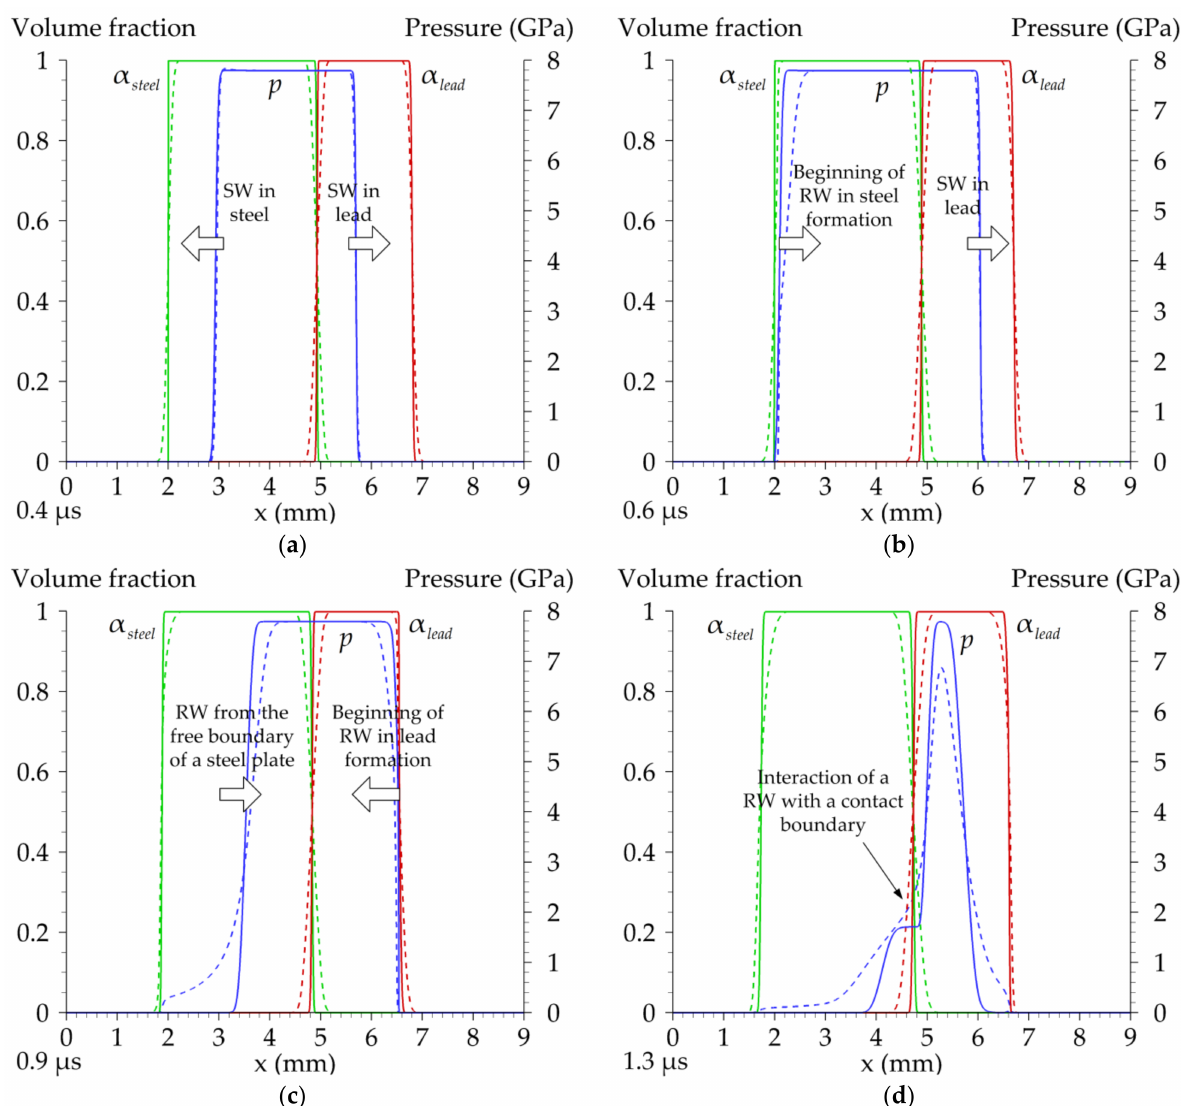
Figure 2. Predicted spatial distributions of α steel (green color), α lead (red color), and p (blue color) at the successive time moments: ( a ) 0.4 µ s, ( b ) 0.6 µ s, ( c ) 0.9 µ s, ( d ) 1.3 µ s; h steel = 3 mm, h lead = 2 mm. Dashed lines correspond to the HLL simulation, solid lines correspond to the HLLC